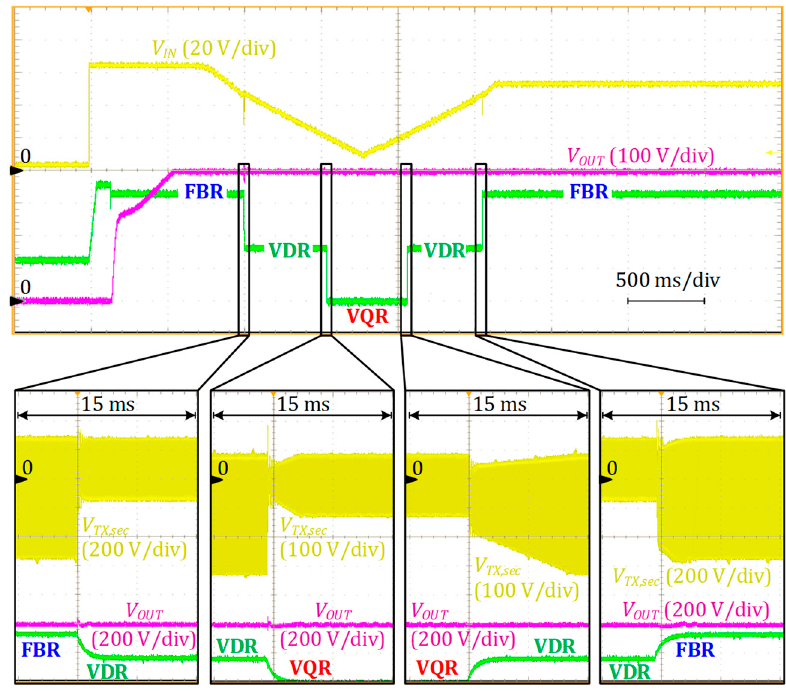
Figure 13. Closed-loop operation of the converter with BHBI.